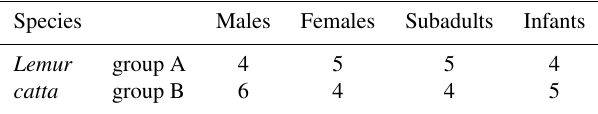
Table 1. Composition of the two ring-tailed lemur groups at Affen- wald during the events. Group A is the focal group described in this study. Species Males Females Subadults Infants Lemur group A catta group